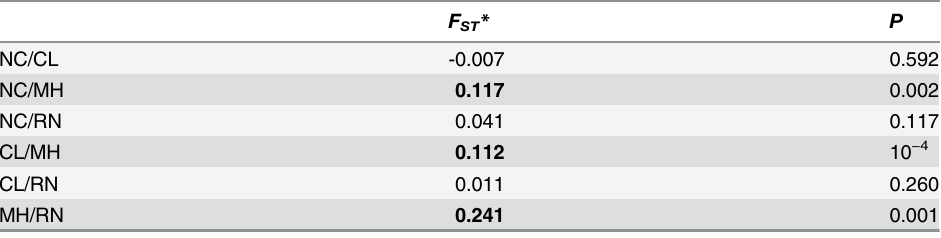
Table 2. Pairwise genetic differentiation between putative populations.